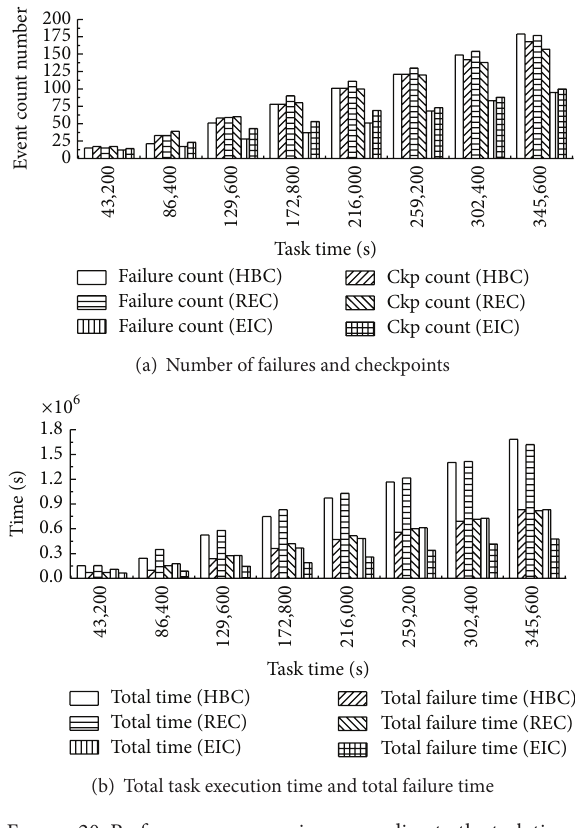
Figure 20: Performance comparison according to the task time.